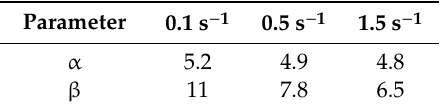
Table 3. Values for α and β parameters determined from the fitting of Olson–Cohen equation to 201L + Ti steel at di ff erent rolling strain